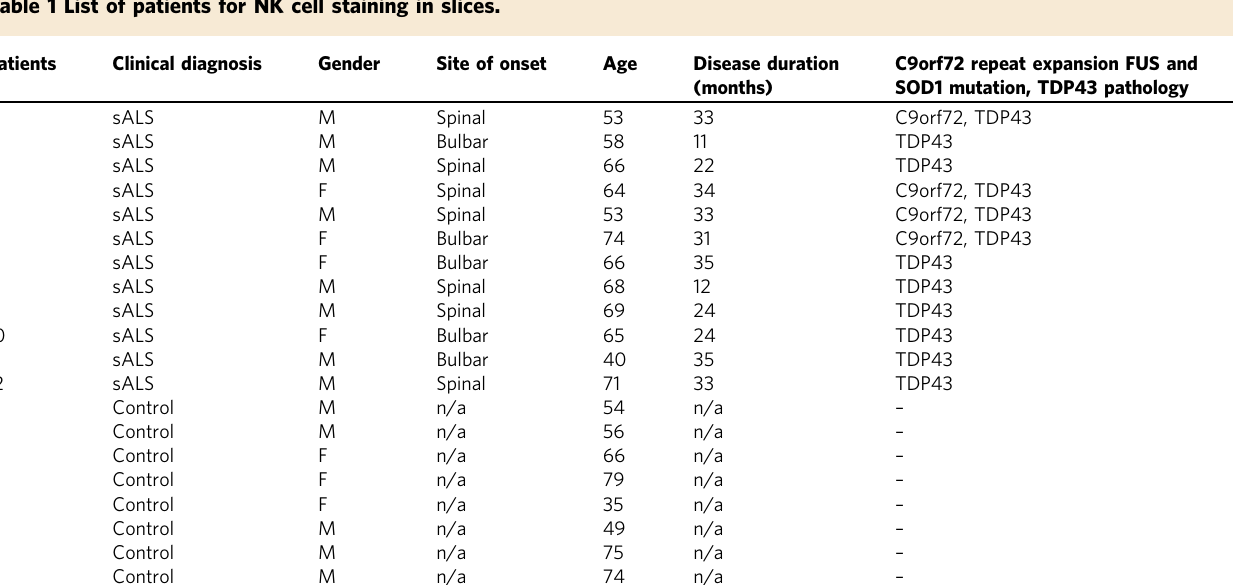
Table 1 List of patients for NK cell staining in